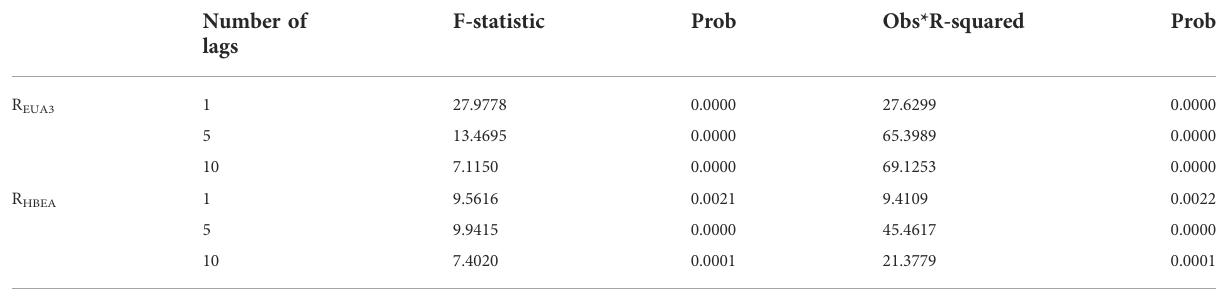
TABLE 4 ARCH-LM test results. The null hypothesis is that a series of residuals exhibits no conditional heteroscedasticity. The p -value represents the signi fi cance of the corresponding test. Number of F-statistic lags